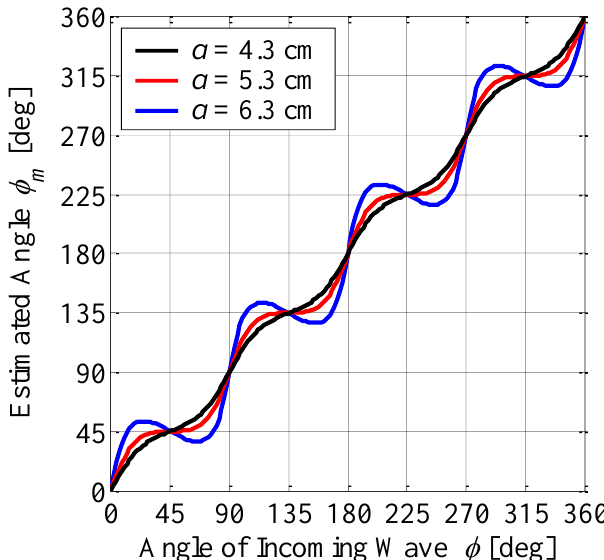
Figure 4. Estimation angle vs. angle of incoming wave.